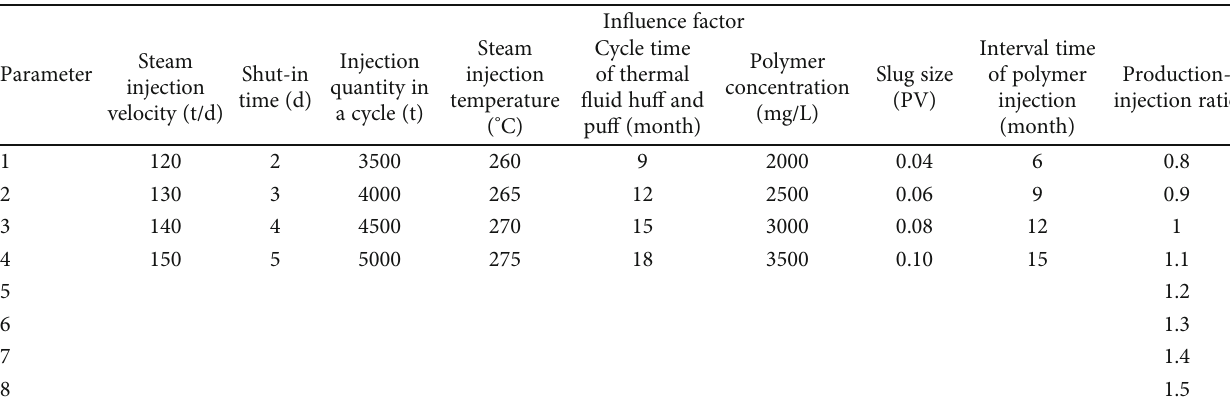
Table 8: Orthogonal design factors and level values in the combined